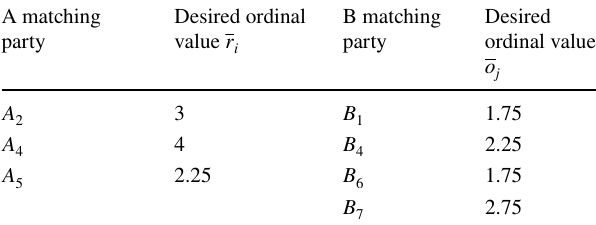
Table 5 Desired ordinal value by the individuals with the weak per- ceived difference type